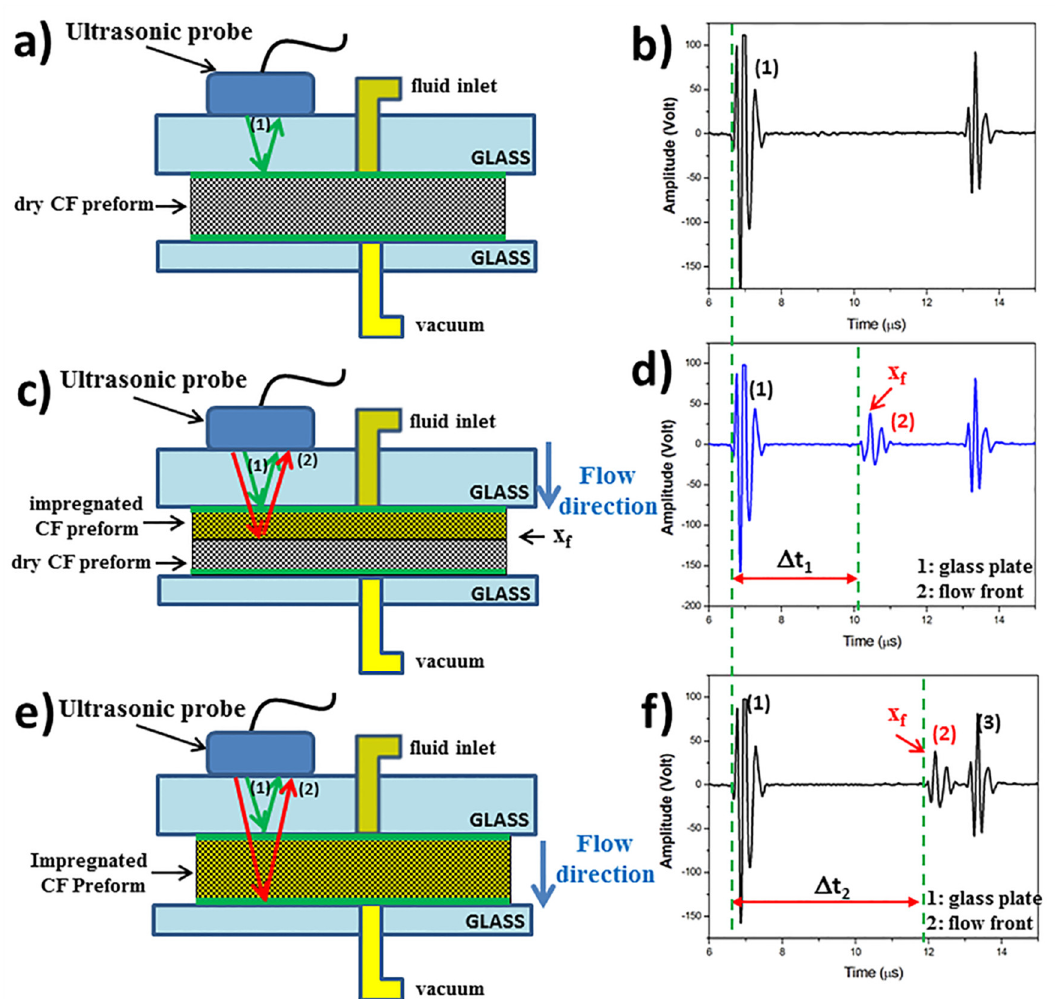
Figure 5. Ultrasonic wave path and corresponding echograms at different stages of the impregnation process: ( a , b ) no impregnation; ( c , d ) partial impregnation;( e , f ) complete impregnation.